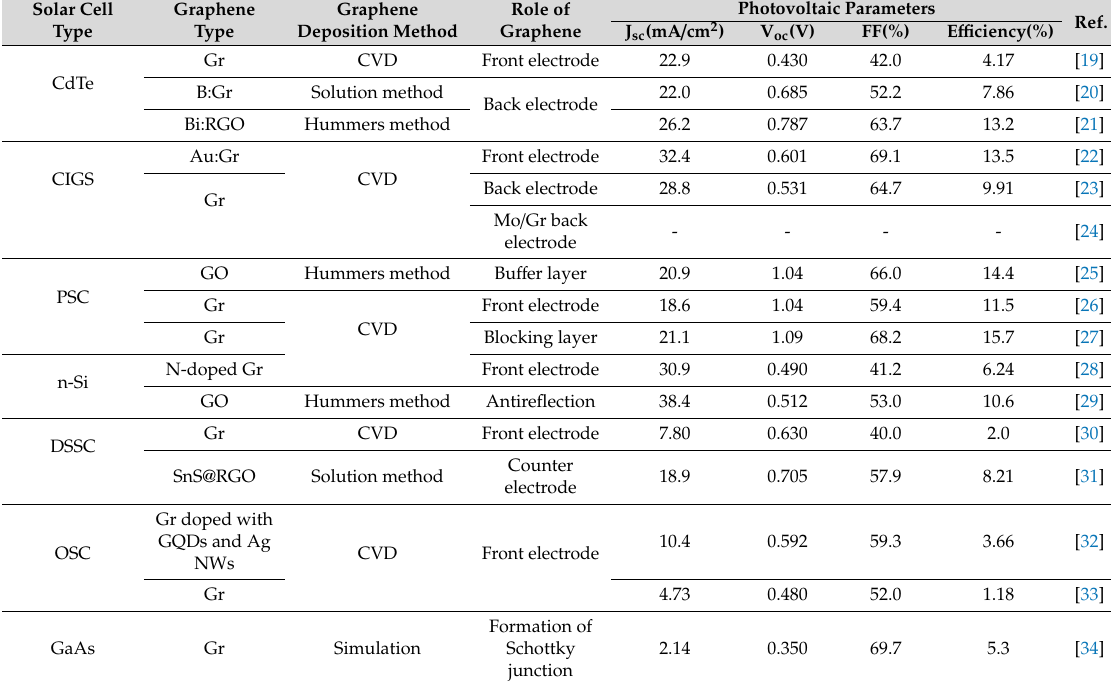
Table 1. Applications of graphene or its derivatives in solar cells and reported device